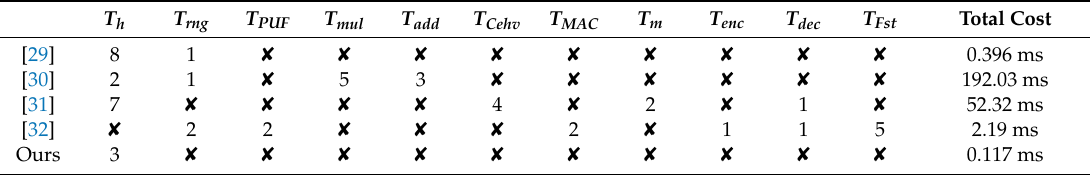
Table 3. Number of each cryptographic operation used in one execution of each protocol and the computational cost for EV.